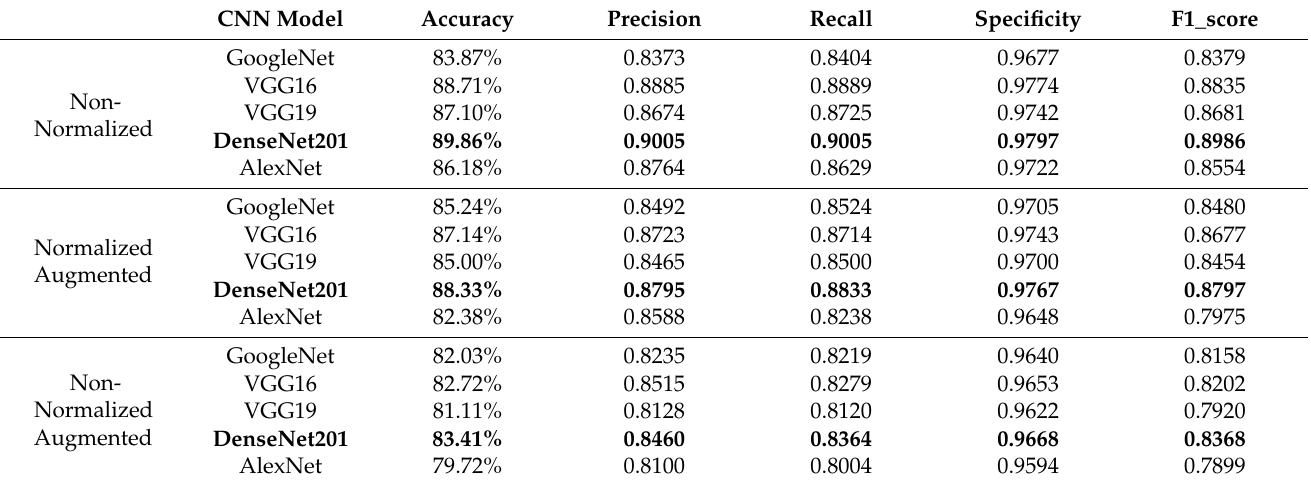
Table 3. Comparison of experimental results using different well-known CNN architectures with their trained